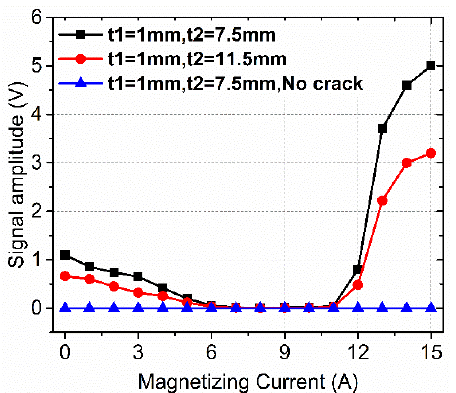
Figure 13. The relationship between signal amplitude and magnetizing current.